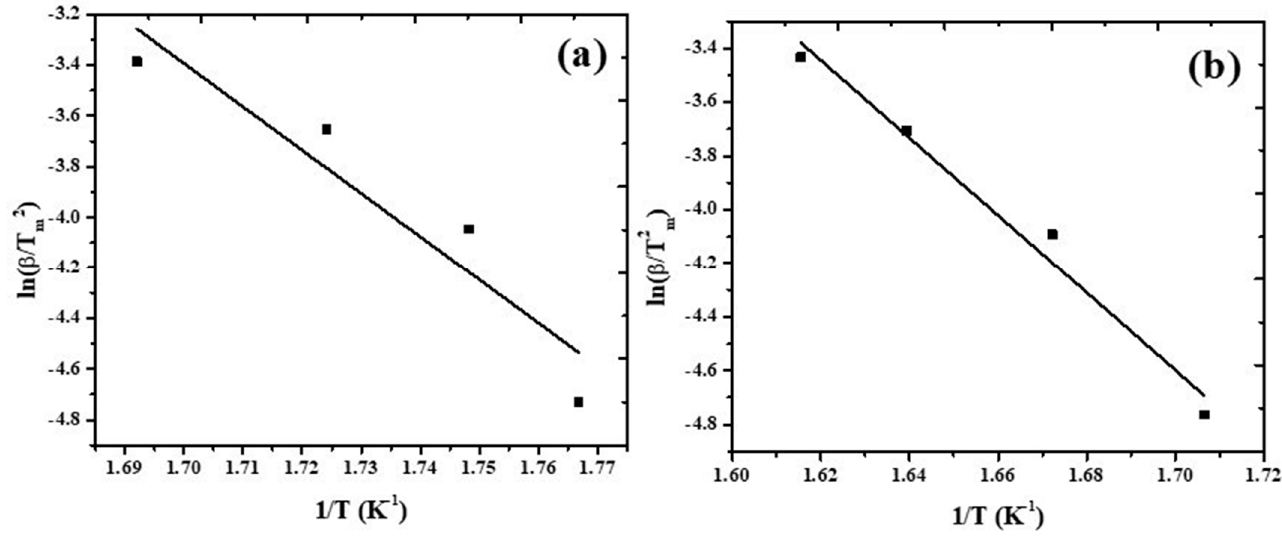
Figure 2. Kissinger plots constructed from ( a ) thermal and ( b ) thermo-catalytic decomposition of lignin. Table 1. Determination of Kinetic parameters applying Kissinger equation.